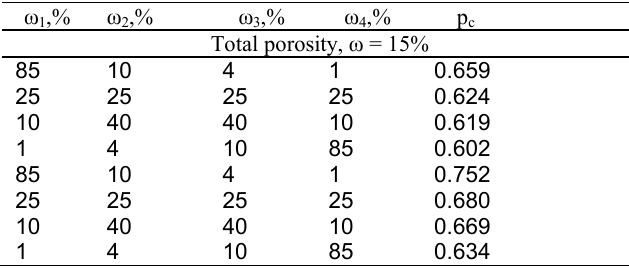
Table 1. Dependence of the percolation threshold